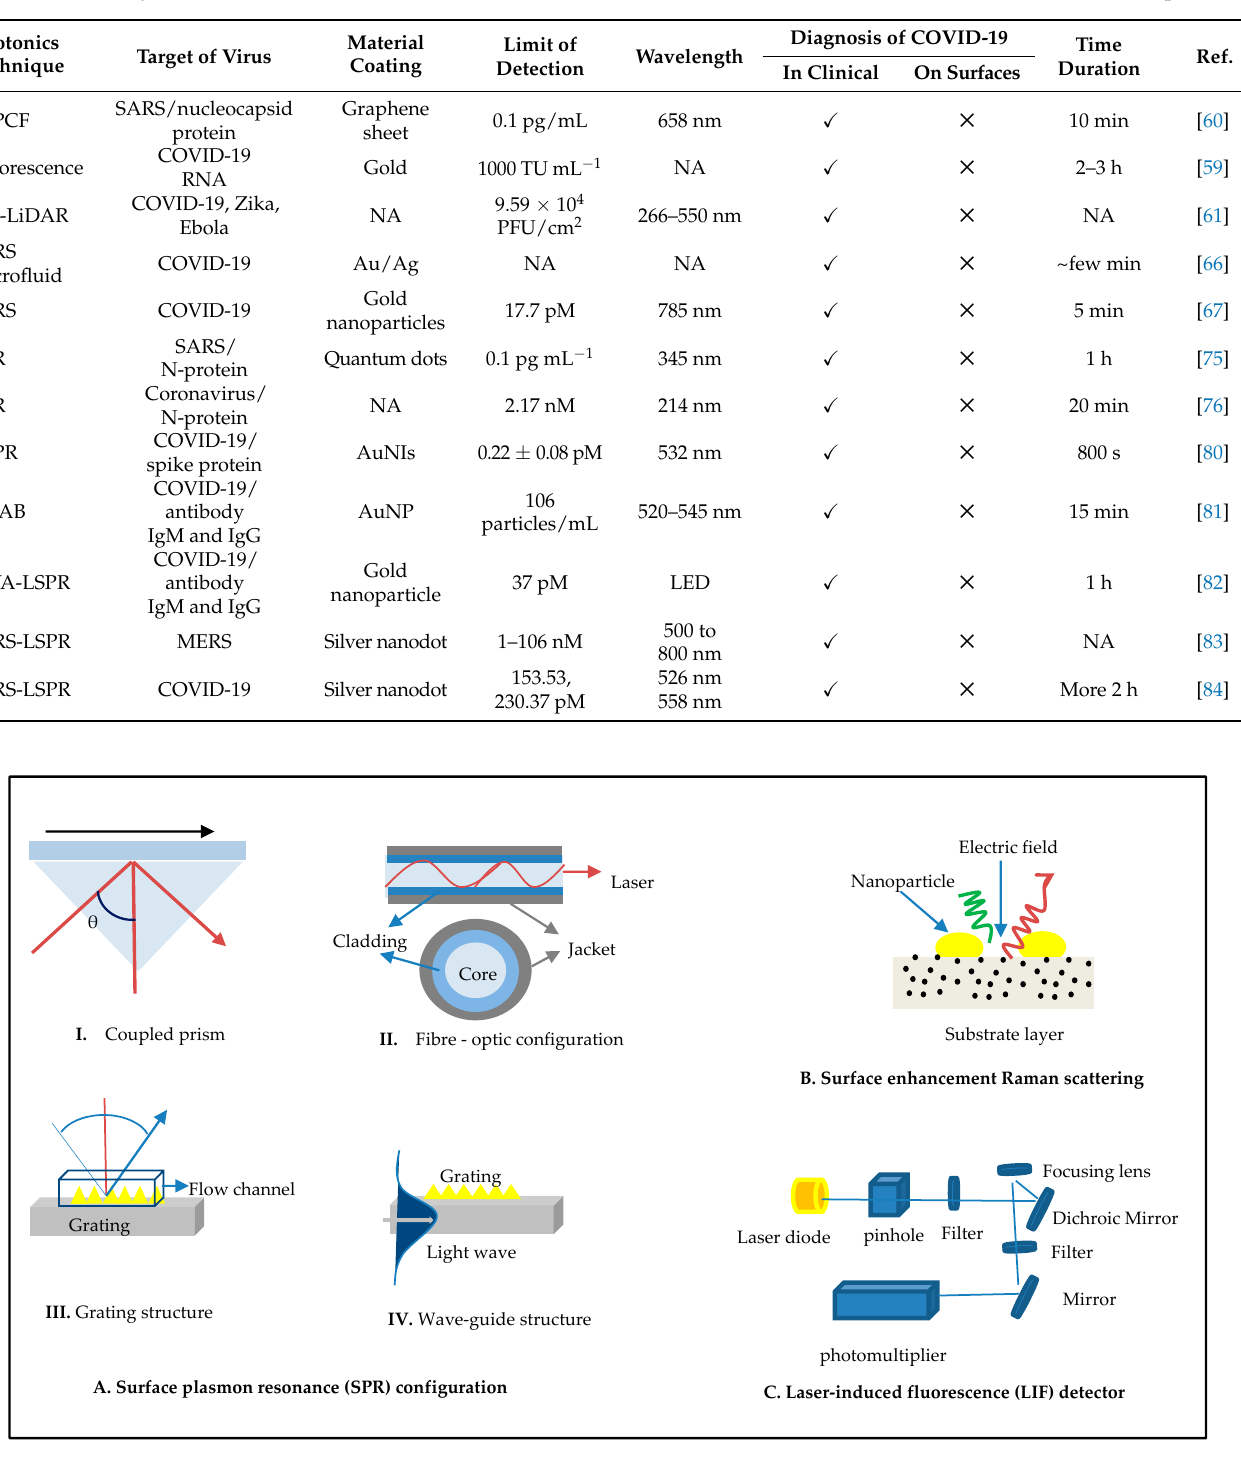
Table 2. Analysis of studies in the literature on the detection of coronavirus disease (COVID-19) based on laser techniques. Photonics Technique